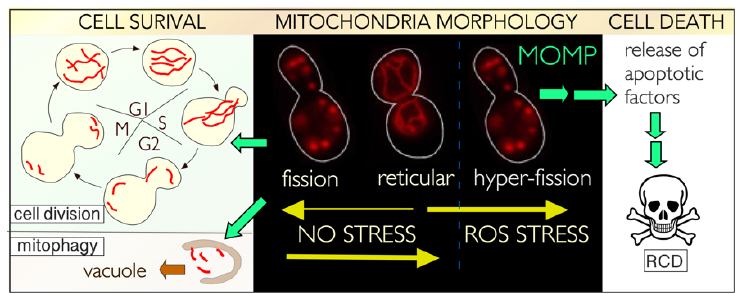
Figure 5. Outline of the different mitochondrial dynamics observed in unstressed and ROS (Reactive oxygen species)-treated yeast cells. See text for details. The fluorescence images are of budding yeast harboring a Mt-DSRed plasmid that localizes to the OMM (outer mitochondrial membrane). MOMP—mitochondria outer membrane permeabilization, RCD—regulated cell death.